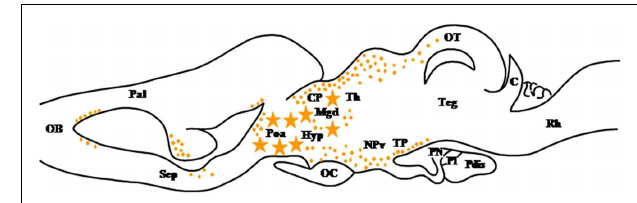
FIGURE 5 | Schematic parasagittal section depicting the distribution of 17 β -hydroxysteroid dehydrogenase (17 β -HSD)-immunoreactive cell bodies (stars) and fibers (dots) in the central nervous system of Rana esculenta (Mensah-Nyagan et al., 1996a,b). For other designations, see Figure 2 .